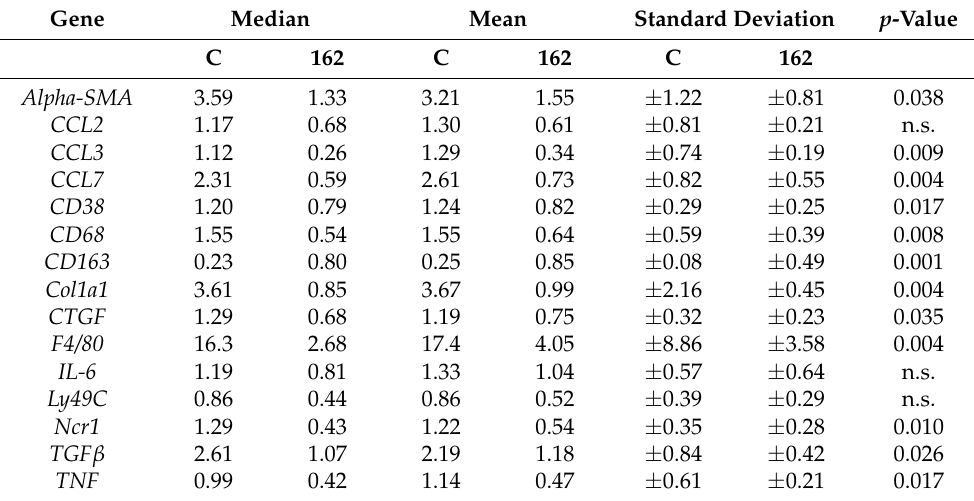
Table 2. Median, mean, standard deviation, and p -values of genes expressed in the liver of control (C) and muChem-162 (162)-overexpressing mice after feeding them an methionine–choline deficient (MCD) diet for 2 weeks. For normalization, 18S rRNA was used. Genes were ordered alphabetically. n.s., not significant. ( n = 7 mice per group; Mann–Whitney U test). Gene Median Mean Standard Deviation p -Value